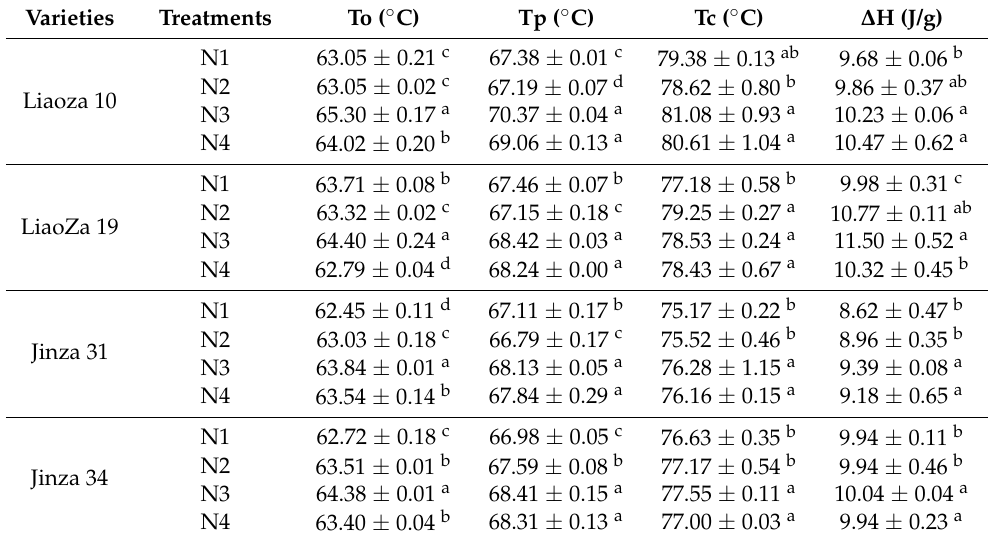
Table 4. Effects of different nitrogen fertilizer level on thermal enthalpy of sorghum